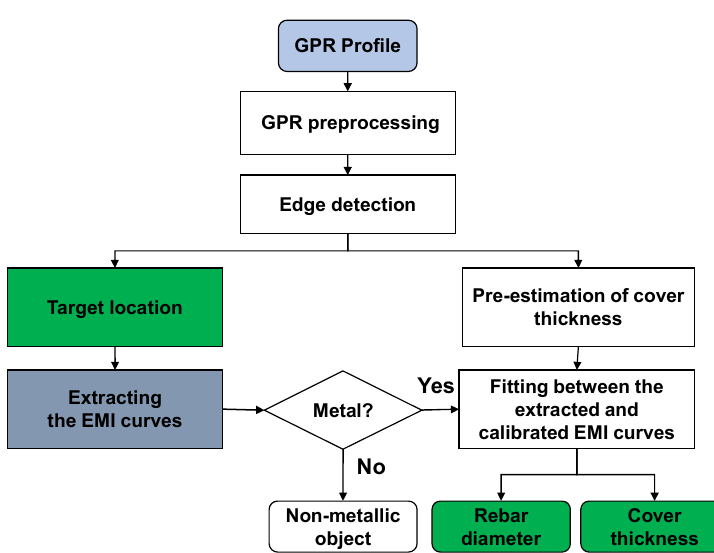
the coils are right above the rebars during the calibration experiment.